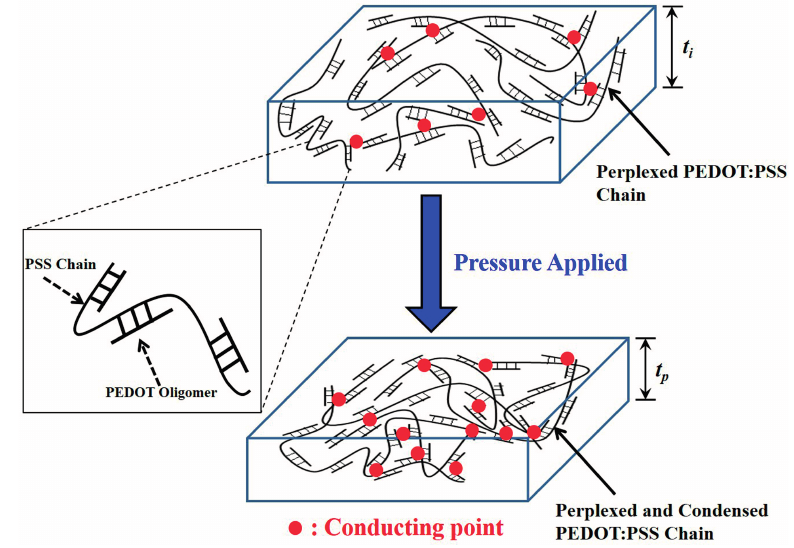
Figure 6. Conducting mechanism of the poly(3,4-ethylenedioxythiophene):polystyrene sulfonate (PEDOT:PSS) chains in the compressed mode. The red points illustrated the conducting points within the PEDOT:PSS film. Perplexed PSS chain with connected PEDOT oligomers was shown in the enlarged